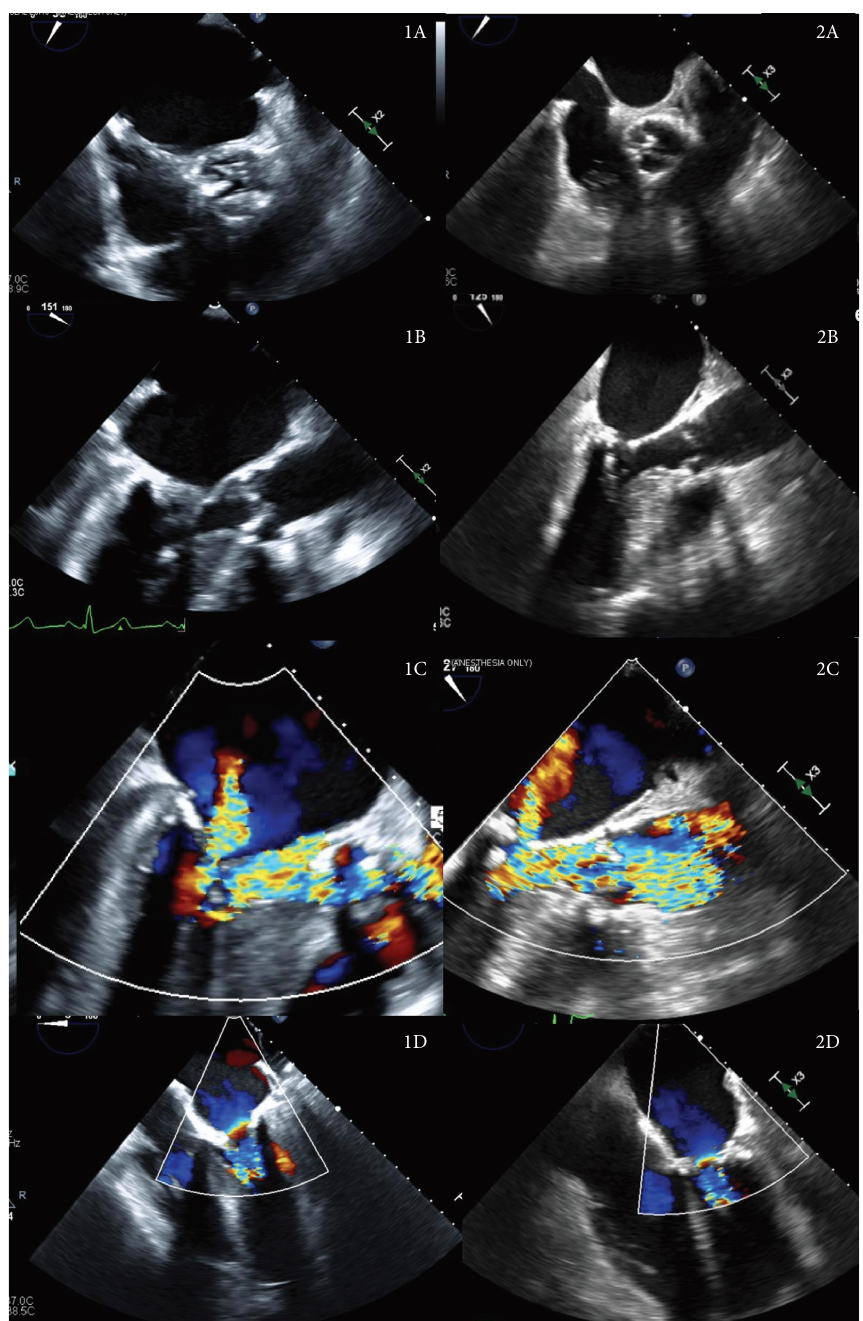
Figure 1: Pre-cardiopulmonary bypass transesophageal echocardiographic views for Patient 1 (1A–1D) and Patient 2 (2A–2D). A: midesophageal aortic valve short-axis view. B: midesophageal long-axis view during systole with SAM. C: midesophageal long-axis view during systole with SAM and color-fow Doppler. D: midesophageal four-chamber view with color-fow